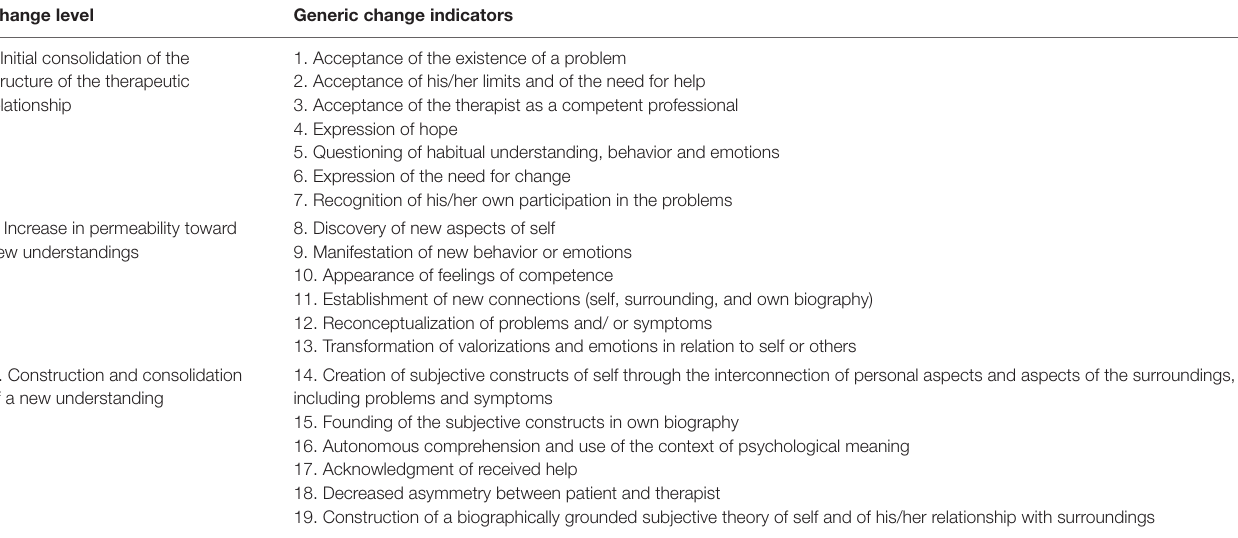
TABLE 1 | Generic change indicators (taken from Krause et al., 2015).